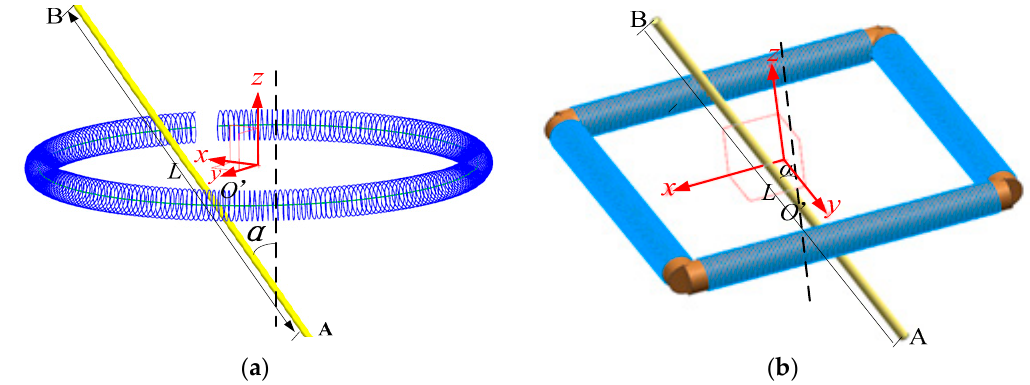
Figure 7. Conductor nonvertically through Rogowski coils ( xOy plane) ( 𝜆 = 0.5 ). ( a ) Rogowski coil of oval skeleton; ( b ) Rogowski coil of rectangular skeleton.